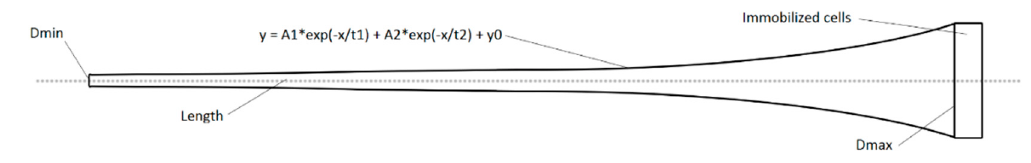
Figure 1. Diagrammatic representation of a tapered optical fiber element (OFE).